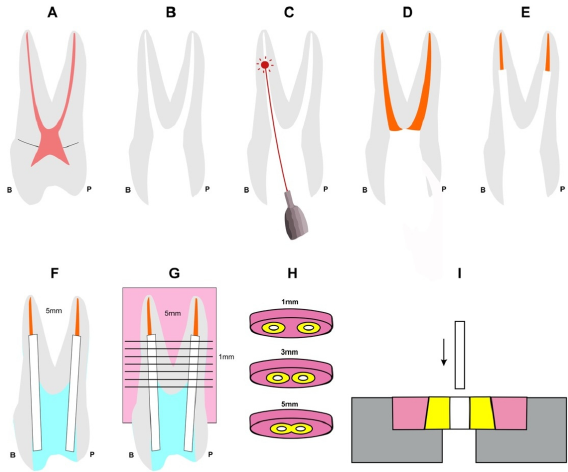
Figure 1. All stages of the experimental procedure. ( A ) sound premolar; ( B ) after cleaning and shaping; ( C ) diode irradiation of the buccal canal; ( D ) endodontic obturation with gutta percha and epoxy resin sealer; ( E ) post space preparation; ( F ) post cementation and restoration of the opening access; ( G ) tooth embedded in epoxy resin and sectioned; ( H ) samples to be tested; ( I ) push-out test performed to an apical-to-coronal direction.